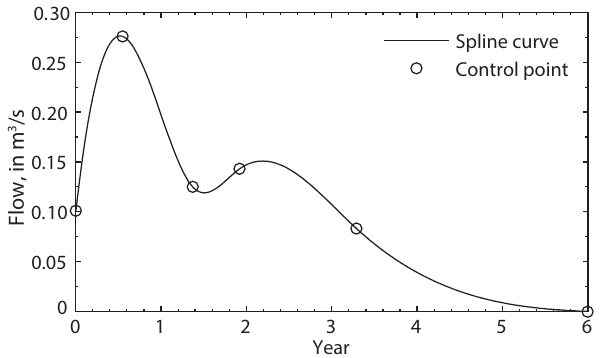
Figure 3. Impulse-response function defined by a spline curve fit through control points. The last control point with a value of zero is not adjusted during model